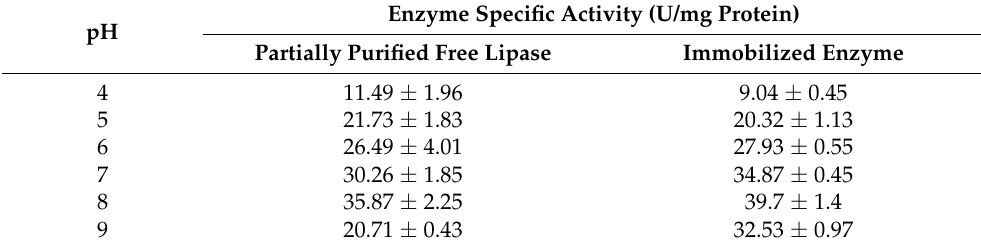
Table 2. Effect of pH concentration of the reaction mixture on the partially purified free enzyme and immobilized lipase-specific activities. The means value of three replicates ± SD is